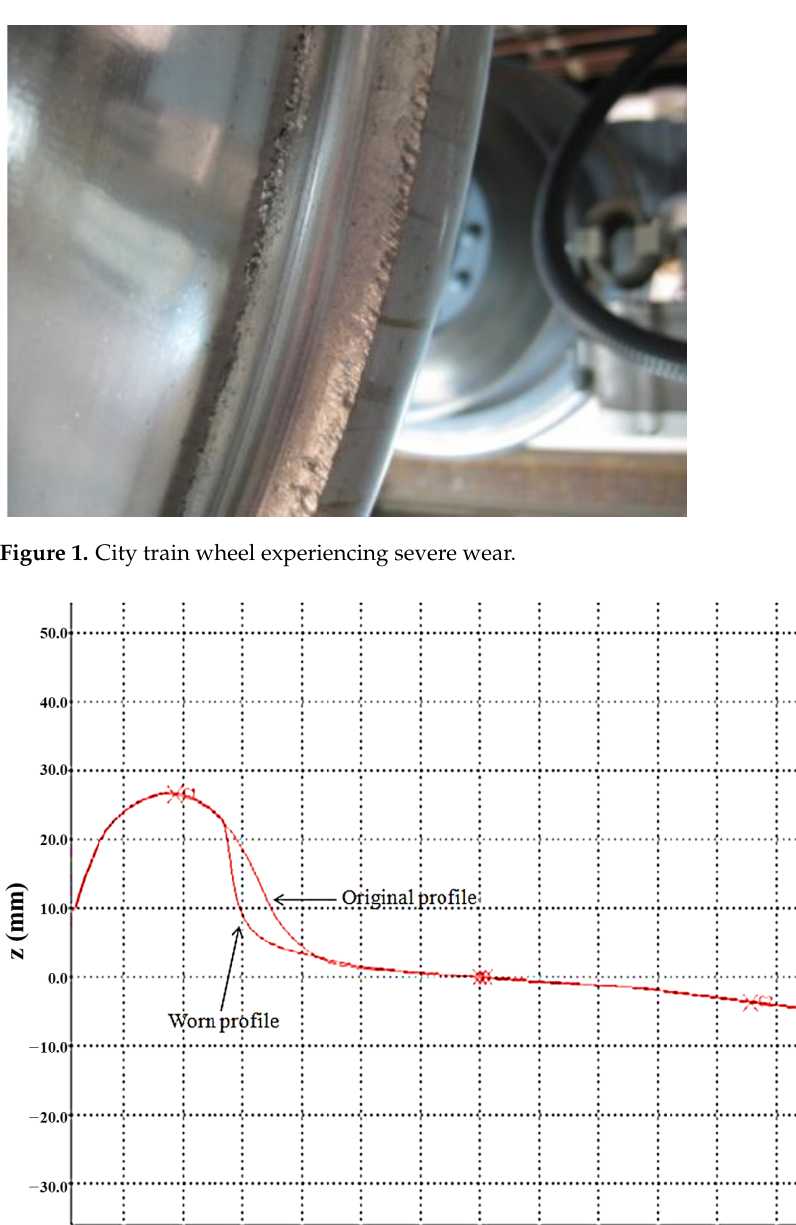
Figure 2. A worn wheel profile after running the distance of approximately 10,000 km.